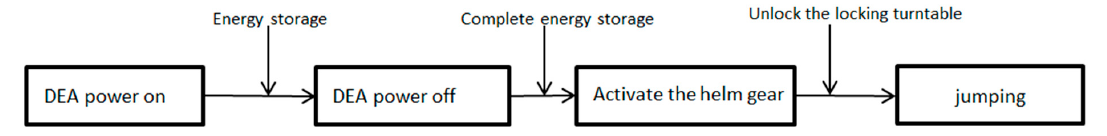
Figure 12. The jumping control of the jumping robot.